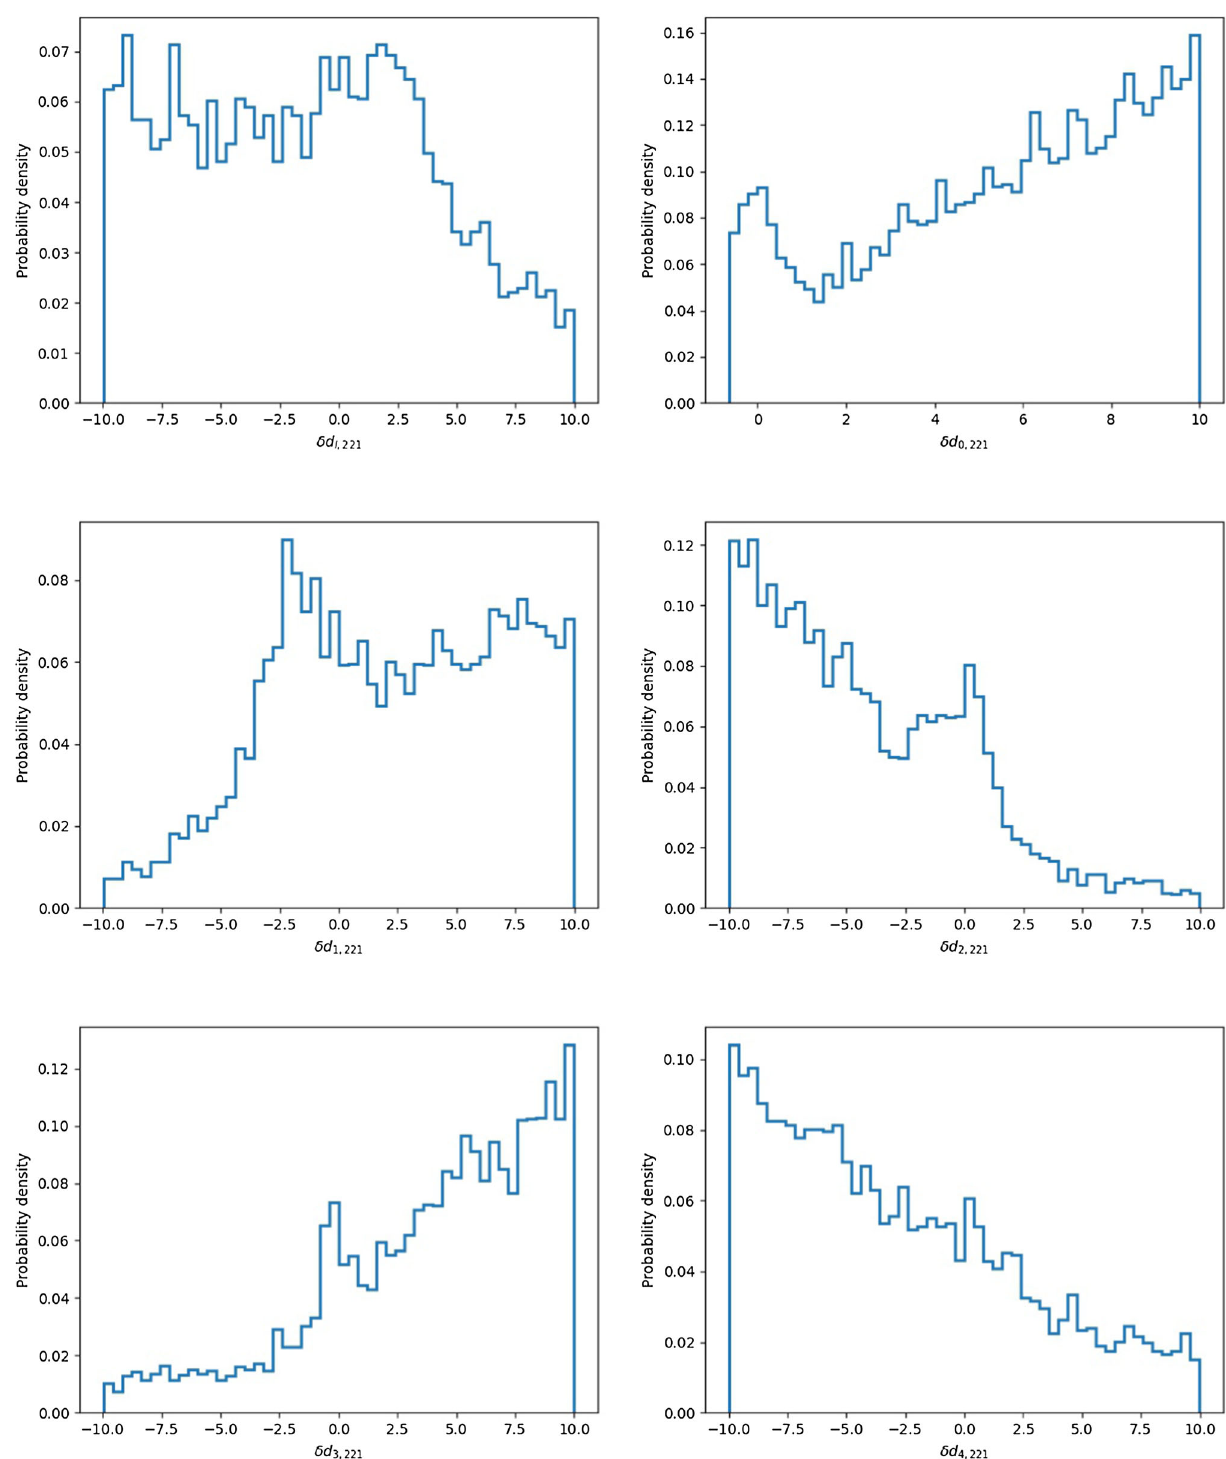
Fig. 2 Posterior distributions for the set of hairs δ d l , i ,